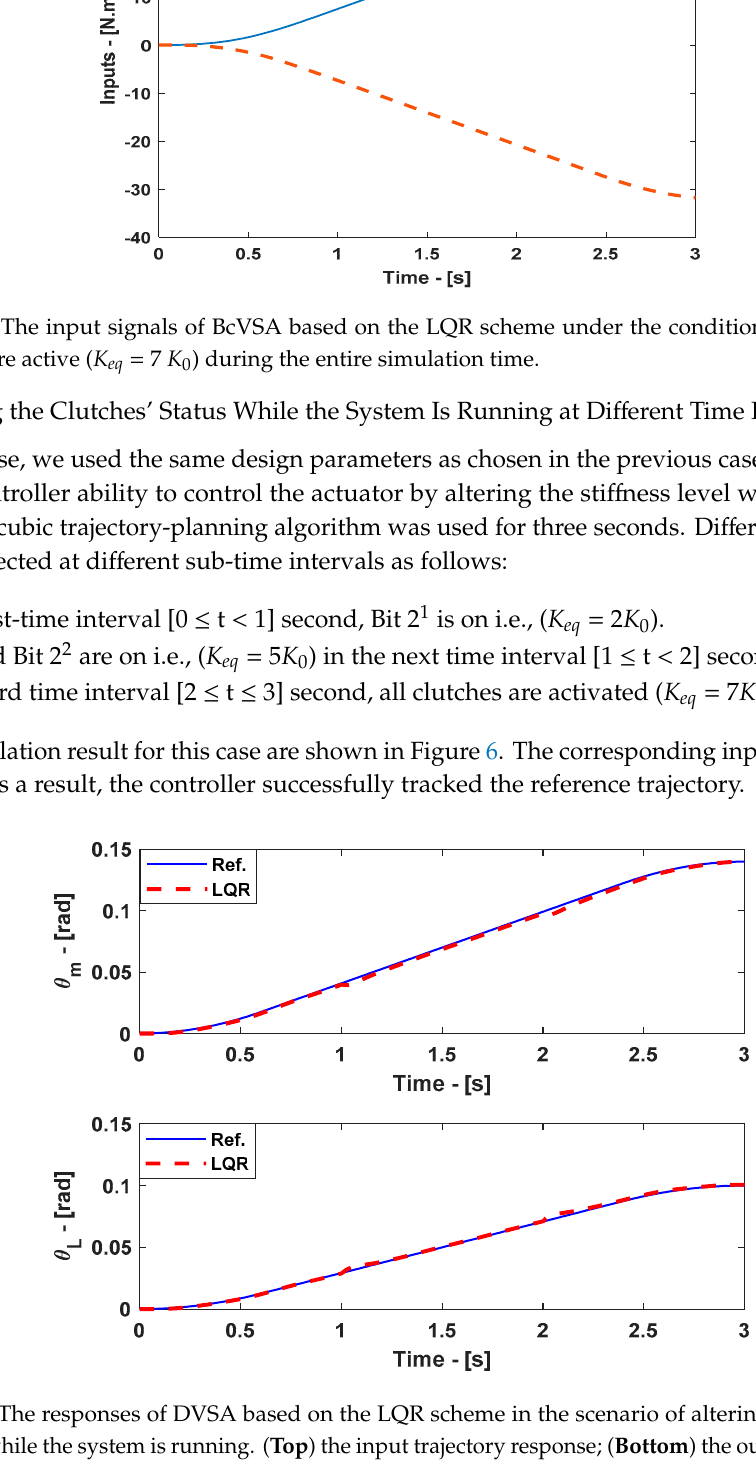
Figure 4. The responses of the BcVSA based on the linear quadratic control (LQR) scheme under the condition when all the clutches are active ( 𝐾 (cid:3032)(cid:3044) = 7 𝐾 (cid:2868) ) during the entire simulation time. ( Top ) the input trajectory response; ( Bottom ) the output response.